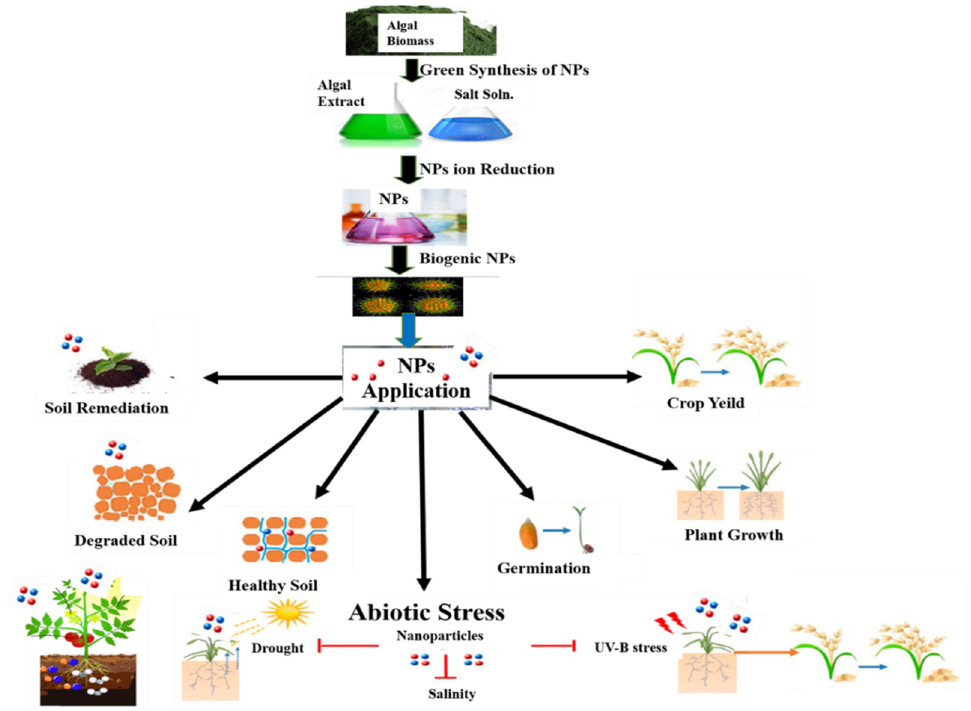
Figure 4. Nanoparticle (NP) application in plant abiotic stress resistance and management.